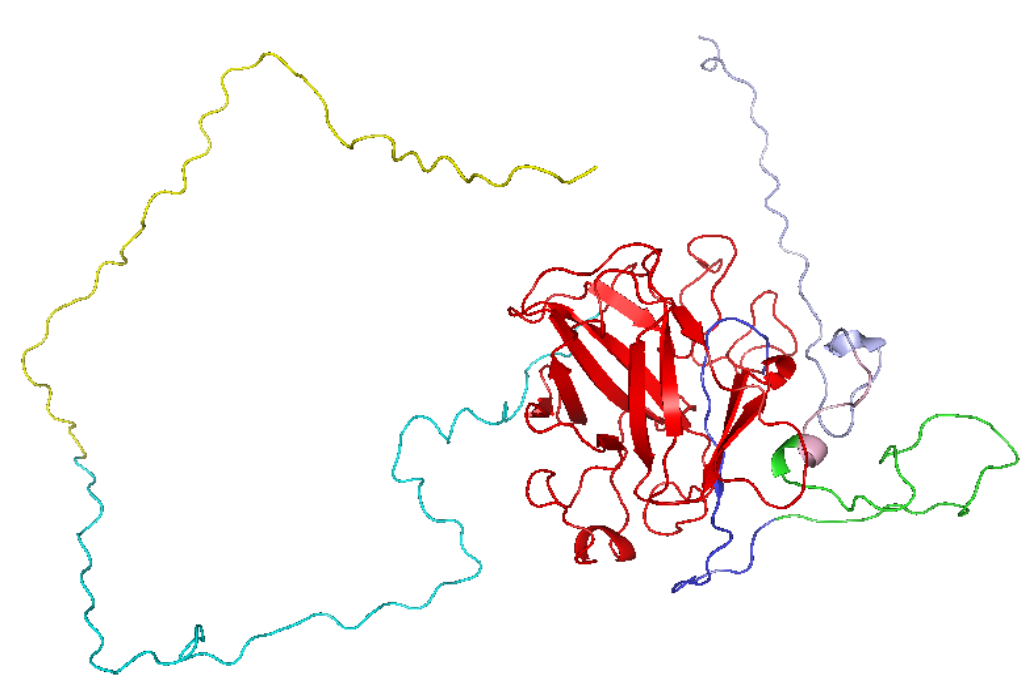
Figure 2. Three-dimensional structure of full length p53 structure. Transactivation domain is represented in yellow, DNA binding domain is shown in red, tetramerization domain is shown in green and regulatory domain is shown in light blue color.